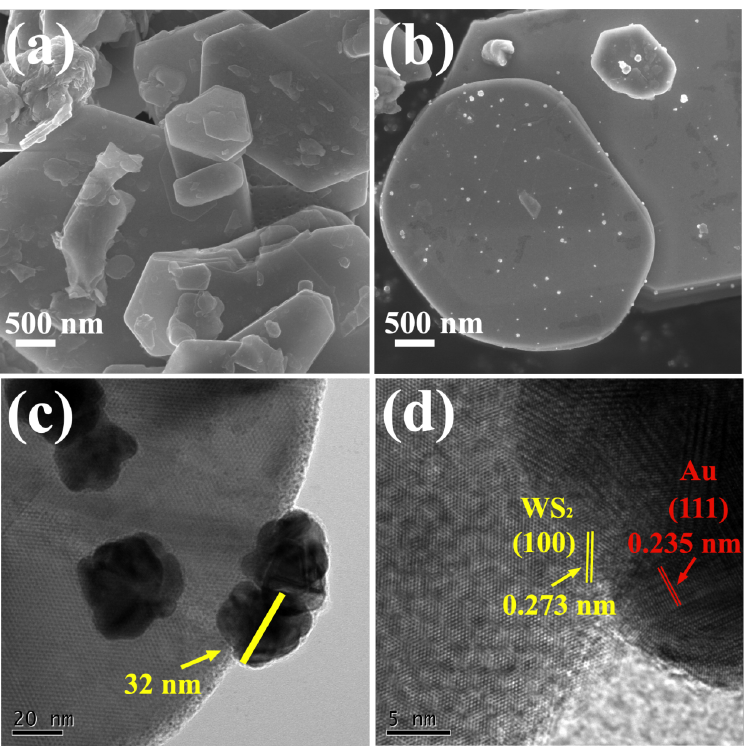
Figure 3. ( a ) FESEM image of pure WS 2 microflakes, ( b ) FESEM image of Au/WS 2 -5.6 nanocom- posites, ( c ) TEM image of Au/WS 2 -5.6 nanocomposites and ( d ) HRTEM image of Au/WS 2 -5.6